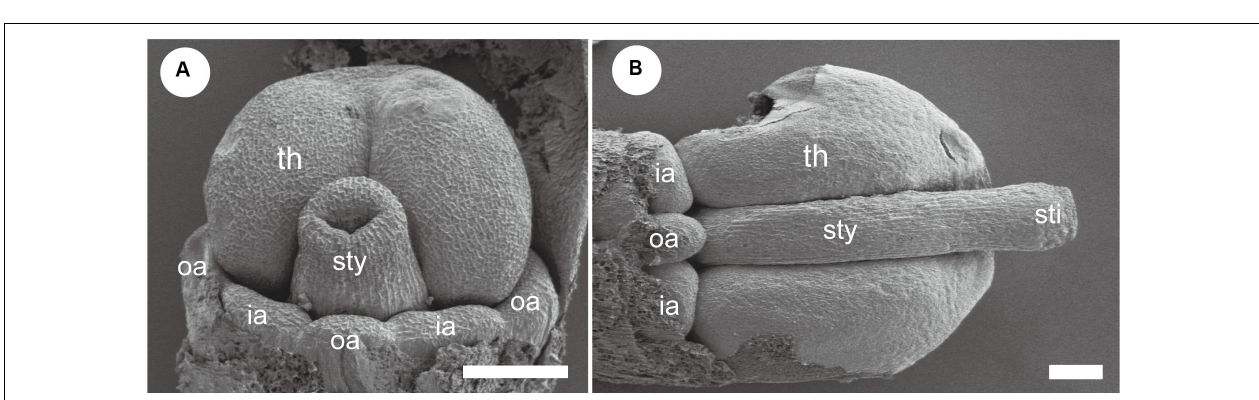
FIGURE 10 | Flower at late mid-developmental stage of Gagnepainia godefroyi. Petals and sepals are removed. (A) Two inner androecial primordia and three outer androecial primordia (oa), including the abaxial primordium are initiated. (B) The style elongates and is enclosed between thecae (th). Two inner androecial primordia (ia) and an outer androecial primordium develop and form the labellum primordium. Abbreviations: ia, inner androecial primordium; oa, outer androecial primordium; pi, pistil primordium; st, stamen primordium. Scale bars = (A) 100 µ m, (B) 500 µ